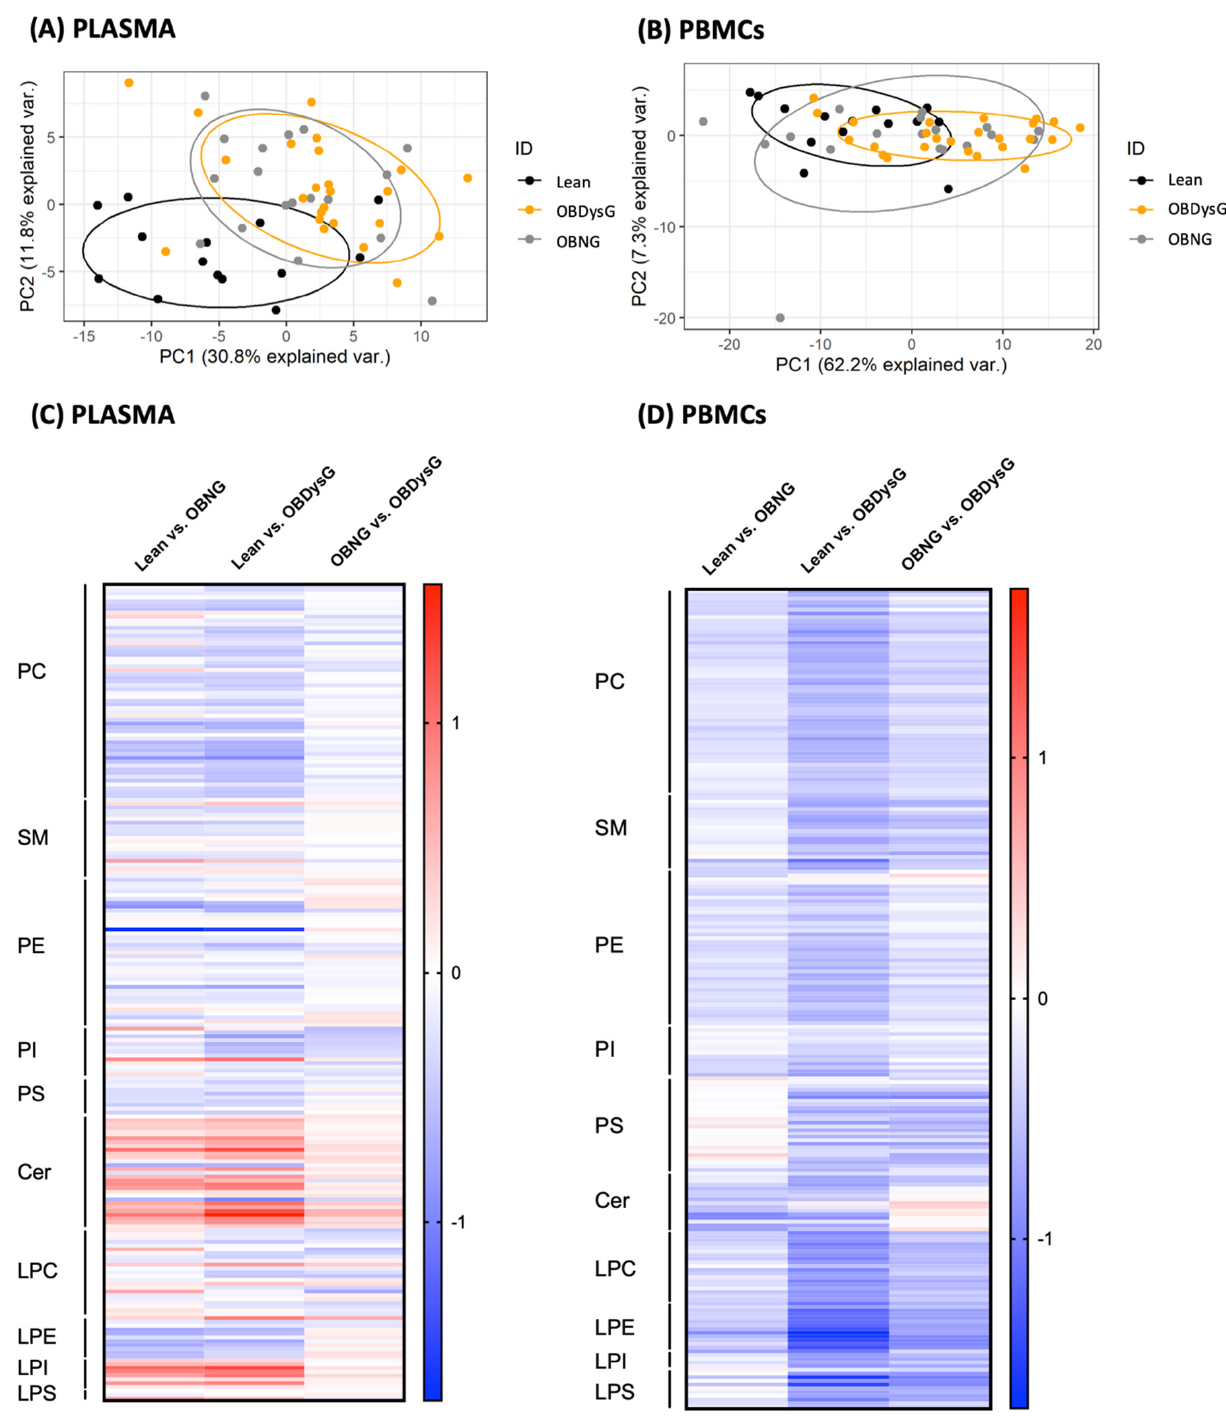
Figure 1. Comparison of both plasma and peripheral blood mononuclear cells (PBMCs) phospholipidome between lean, OBNG and OBDysG patients. Principal component analysis score plot of the lipidomic data (PC, PE, PI, PS, SM) obtained on ( A ) the plasma or ( B ) PBMCs from lean ( n = 14), OBNG ( n = 18) and OBDysG (plasma n = 24 and PBMCs n = 25) patients. Log2FC of all lipid species detected in ( C ) the plasma and ( D ) PBMCs between lean and OBNG or OBDysG patients and between the two obesity phenotypes (OBNG vs. OBDysG).